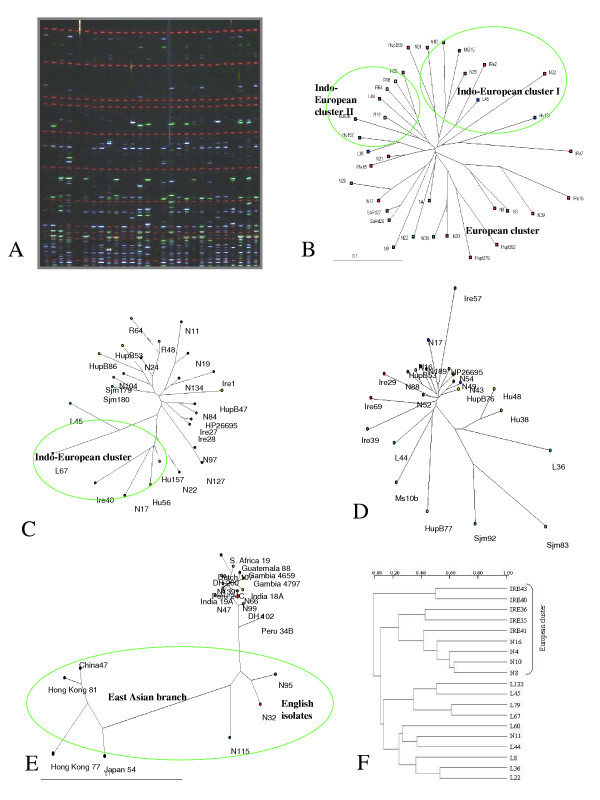
(A) shows a gel image of representative FAFLP patterns of English H. pylori strains with the bands in red indicating the internal lane standards (Genescan Rox 500). (B) Representative phylogenetic tree indicating genetic relationships between English H. pylori strains (n = 16) and those from other world populations (HupB, n = 3; Ire, n = 3; Italy (Sard), n = 2; R = 2; E. Asia (Hu), n = 2; India (L, MS, BJ), n = 5) based on the FAFLP profiles generated for the strains from different countries (described in the materials and methods section). The neighbour joining network tree created based on the level of similarity between the amplitypes shows that European strains form a distinct cluster although two other clusters showing associations with the Indian strains are also seen. (C) Cluster analysis of the 296 bp glmM was generated with 10 English strains, 2 strains each from India (L), E. Asia (Hu), Peru (Sjm) and S. Africa (R). 4 each from Ire and HupB and the sequenced HP26695. The rounded circle here shows the grouping of English islolate (N 17) with the Indian (L) and E. Asian (Hu) strains. (D) Tree constructed from the babB gene products from different strains (N, n = 8; Ire, n = 4; HupB and MS, L, n = 3 respectively, 2 each of Hu and Sjm with HP26695). (E) Genetic relationships of the English strains based on the 250 bp sequence of the 5'end of the cagA gene (England, n = 7; East Asia, n = 4; S. Africa, n = 1; W. Africa, n = 2; S. America, n = 2; central America, n = 1; India, n = 2; Bangladesh, n = 2 and Holland, n = 1). A few strains from Nottingham showed sequence similarity with the Asian strains as indicated by the circles in green. (F) Phylogenetic tree based on the REP fingerprinting patterns generated by the English strains (n= 5) in comparison with 5 strains from Ire and 6 from India (L).